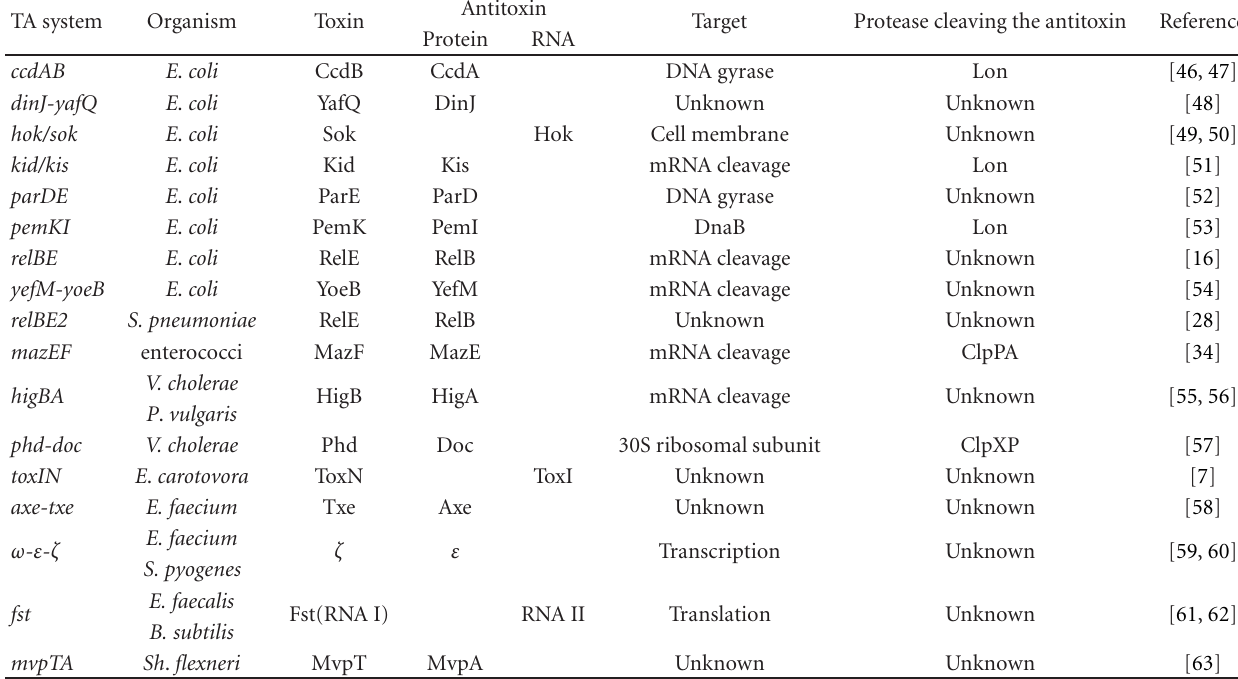
Table 1: Properties of well-characterized TA systems in plasmids.